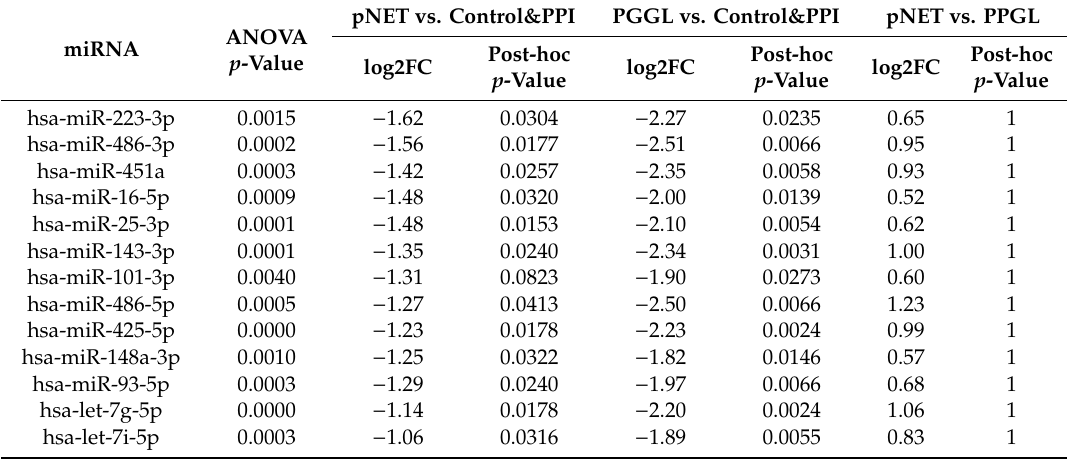
Table 1. 33 miRNAs di ff erentially expressed among controls with or without PPI treatment vs. PPGL vs. pNET groups. (“control&PPI” group includes all healthy controls with and without PPI treatment: “tumor-free” healthy individuals irrespective of the usage of